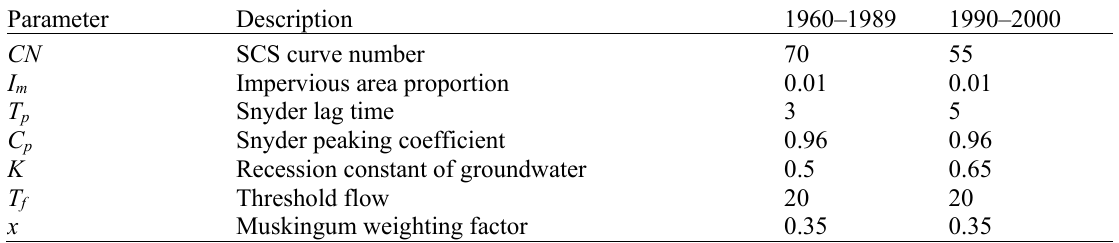
Table 1 The calibrated parameter values for the two